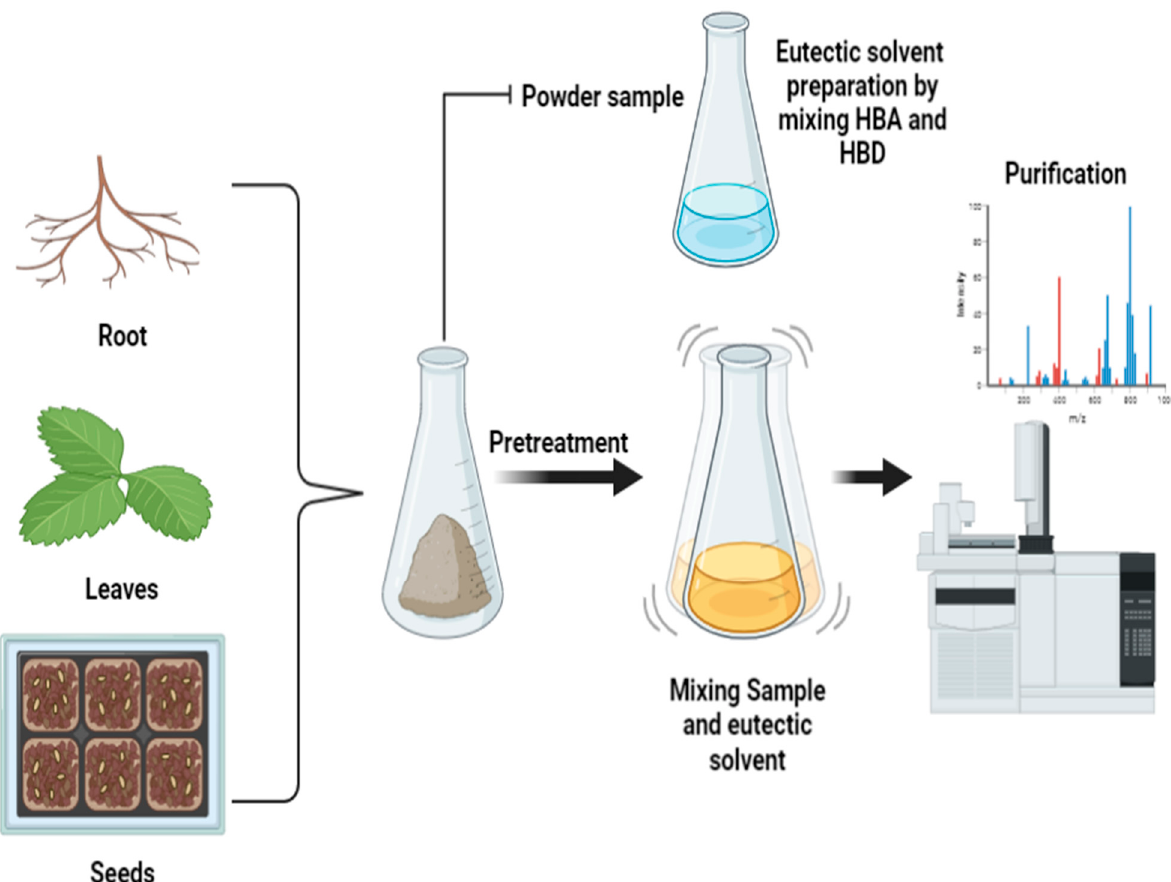
Figure 13. A diagrammatic representation of natural deep eutectic solvent extraction.